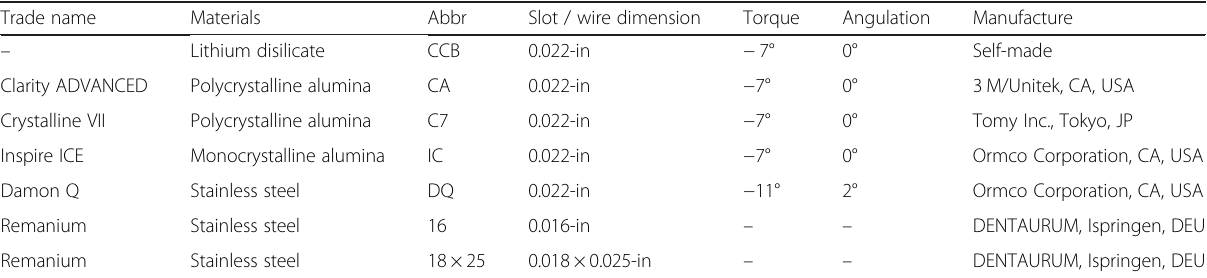
Table 1 Materials